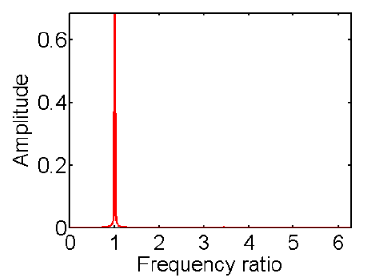
Figure 9. Spectrum diagram of optimized system with no fault.